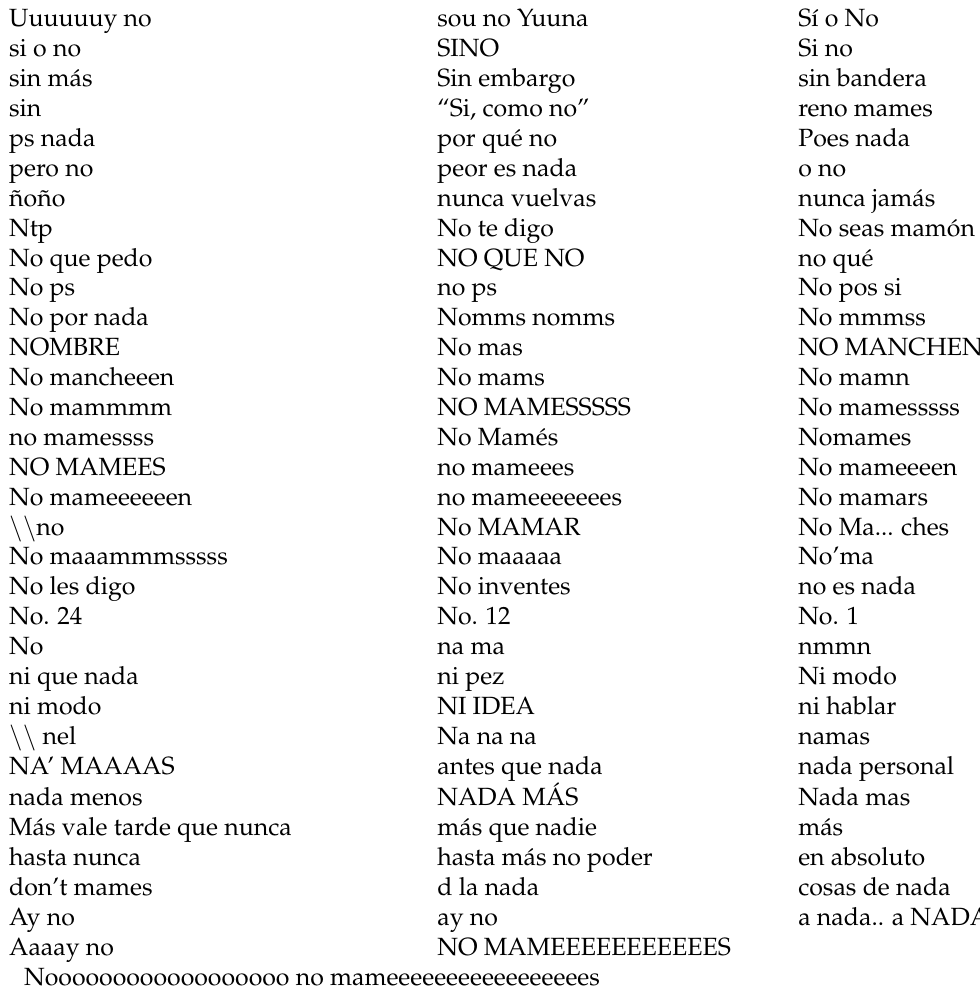
Table A6. Negation cues that were considered as false negation in the corpus, with only one